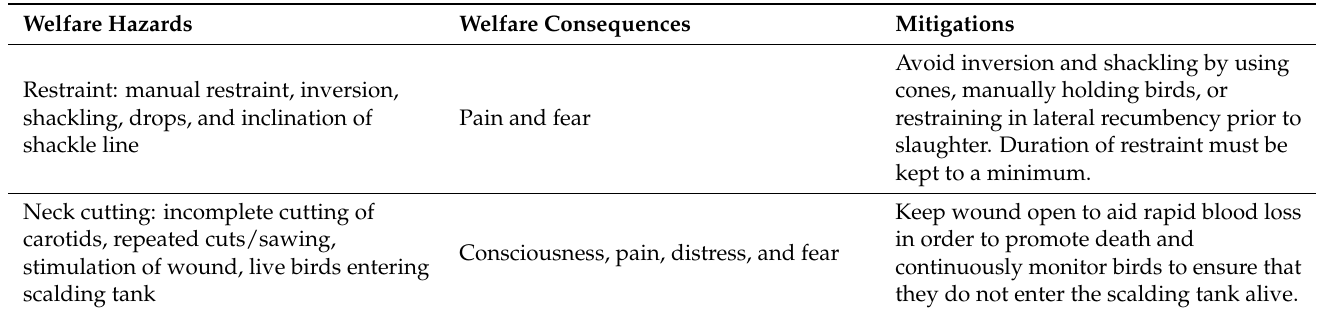
Table 4. Animal welfare hazards, consequences, and mitigations during slaughter without stunning (EFSA